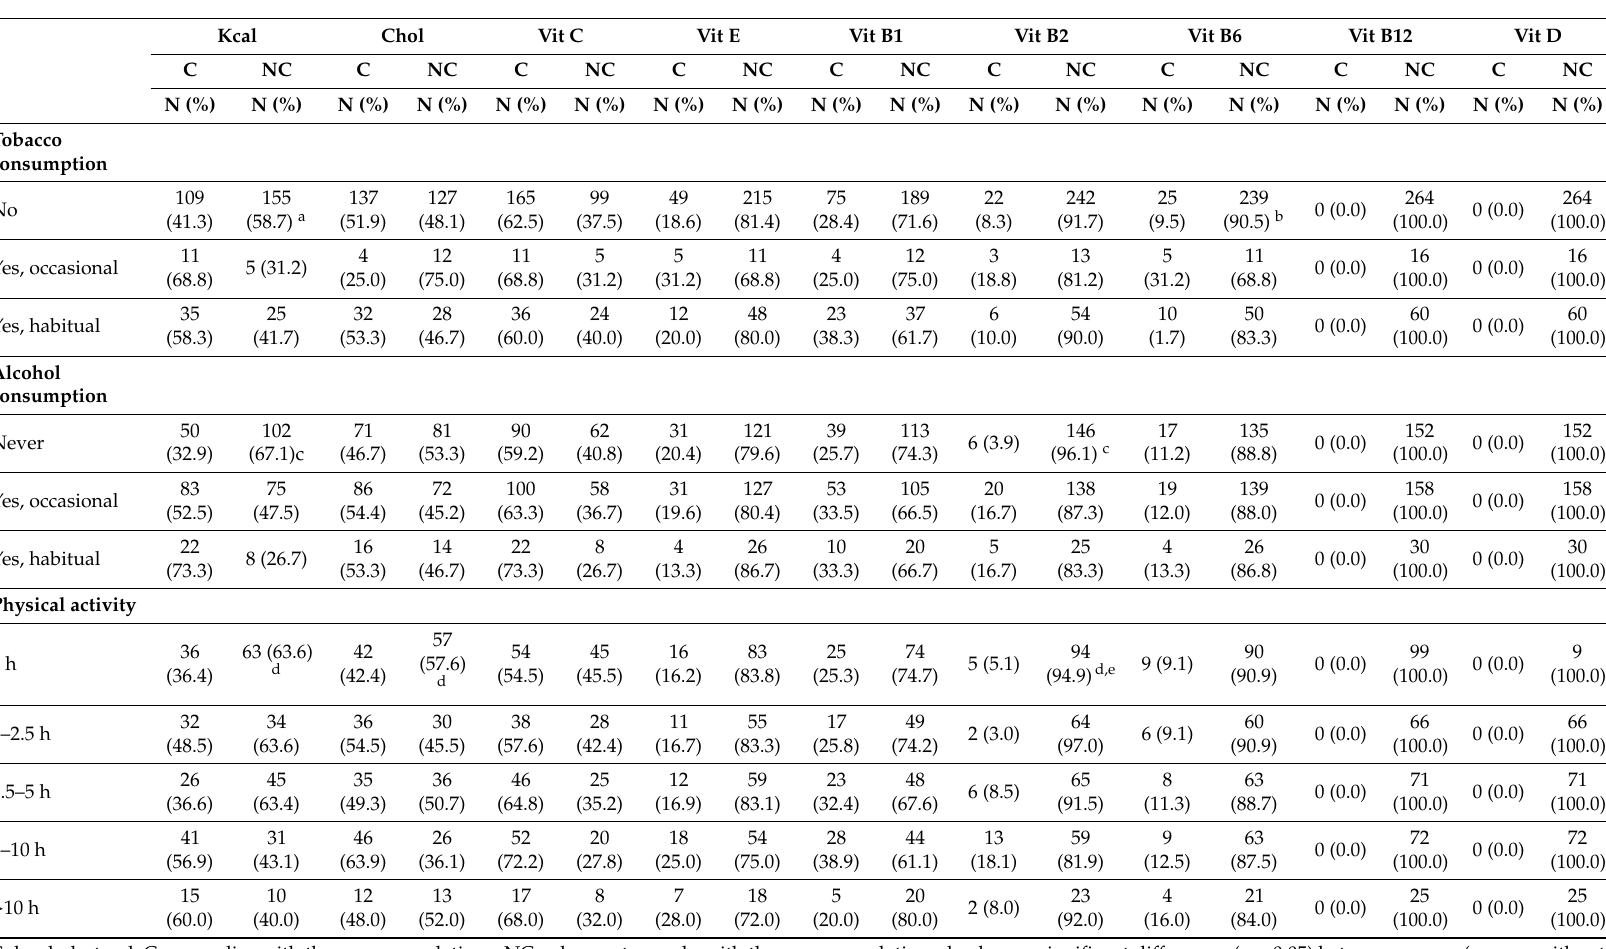
Table 8. Relationship between lifestyle variables and compliance with daily intake recommendations for vitamins, energy, and